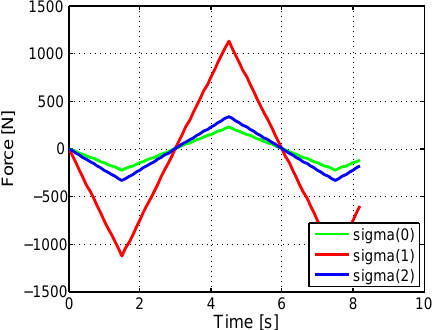
Figure 6. Decomposed applied force at point E according to